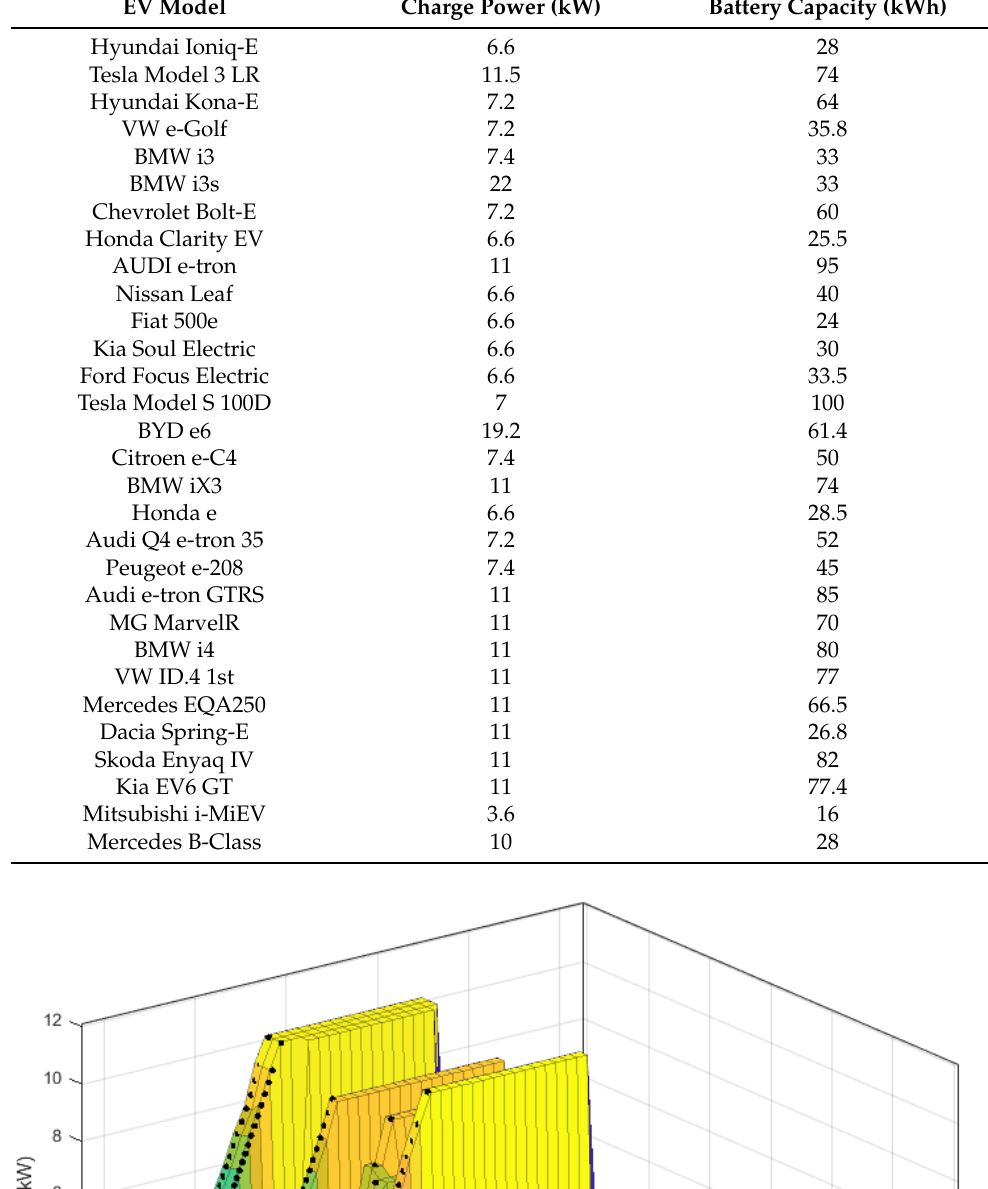
Table 1. Charging Specification of EVs.